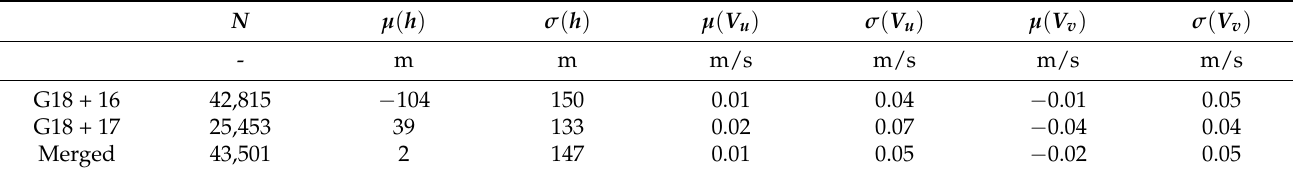
Table 1. Ground Point Retrieval Statistics. Means ( µ ) and standard deviations ( σ ) from a sample size N are calculated with respect the ground truth of the GLOBE digital terrain model. The measured motion with respect to stationary ground is resolved relative to east- and north-pointing directions ( u and v ). Note: GOES-18 Preliminary, Non-Operational